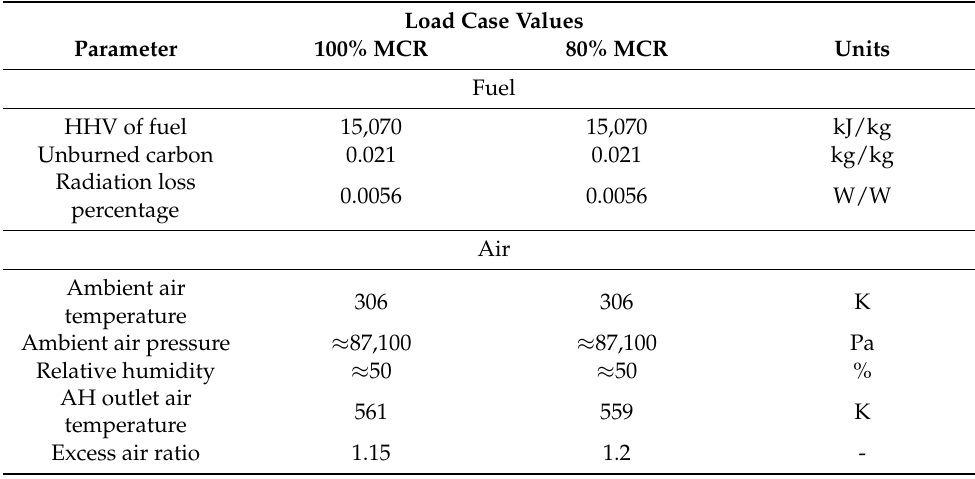
Table 3. Coal-fired boiler case study model inputs (from site